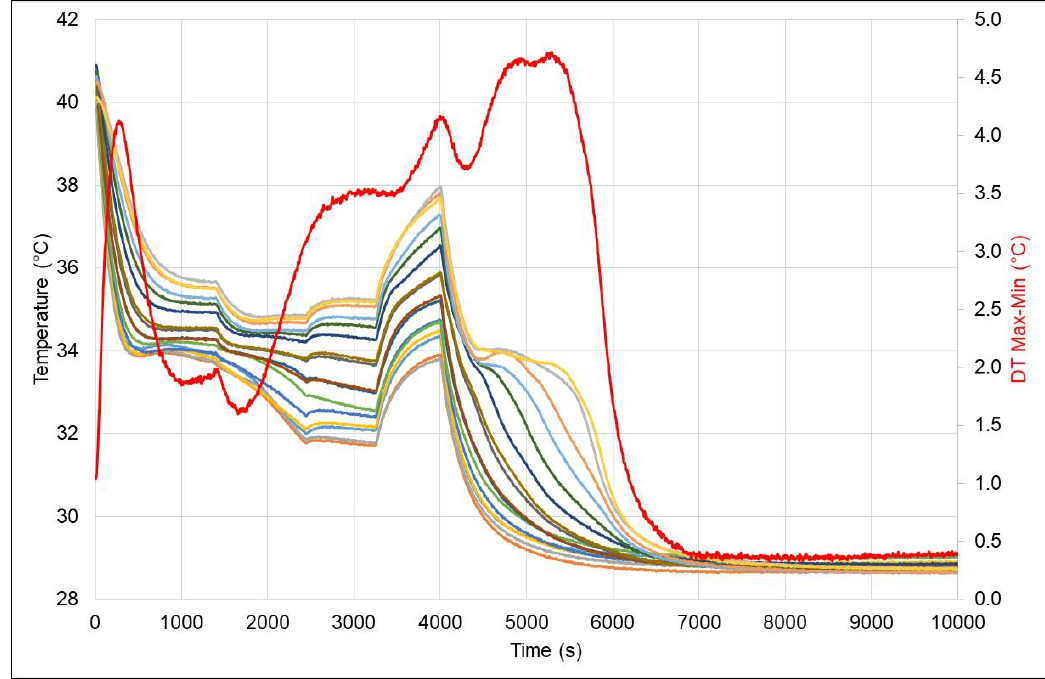
Figure 27. Experimental results with initial temperature of the mockup equal to 40 °C and airflow characterized by V = 2.5 m/s and T = 30 °C.